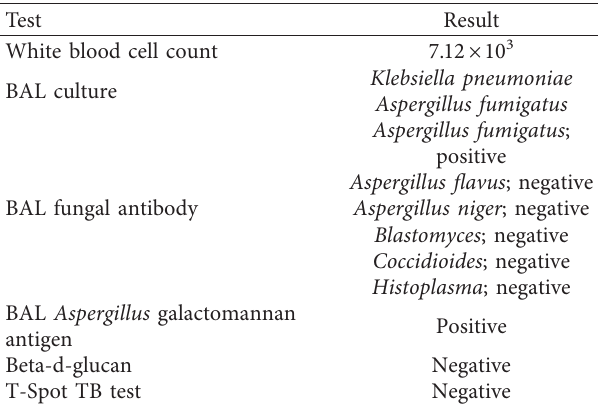
Figure 3: Biopsy of the endobronchial lesion with abundant septate hyphae (blue arrows). Table 1: Various pertinent test